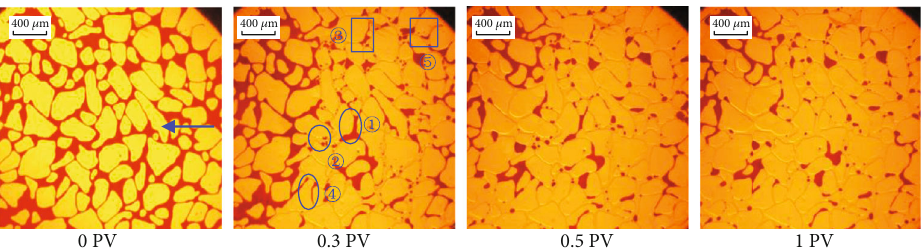
Figure 4: Distribution of residual oil under polymer surfactant fl ooding with a permeability ratio of 1 ( ① cluster, ② oil drop, ③ oil fi lm, and ④ columnar; the red part represents oil; the injection direction of the displacement agents is from right to left).